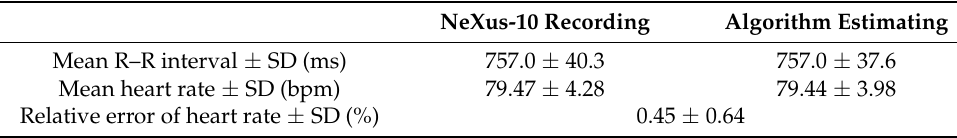
Table 1. R-Wave detection algorithm results (healthy participant).